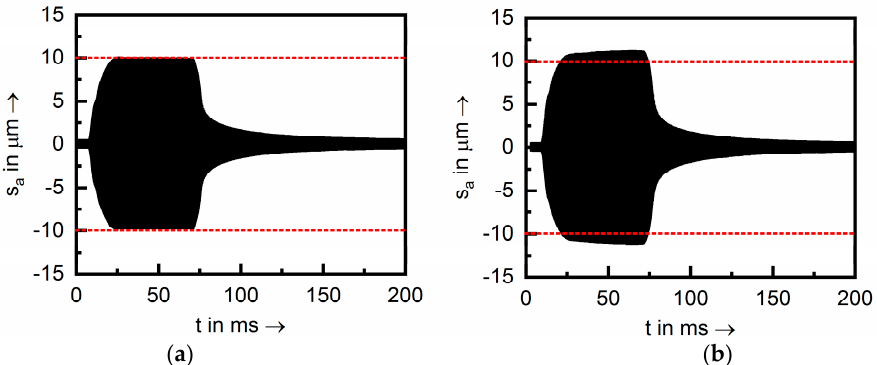
Figure 4. Displacement amplitude of batch A during VHCF testing at ( a ) the beginning of the fatigue test and ( b ) after fatigue-induced α ’-martensite formation occurred without parameter adjustments.